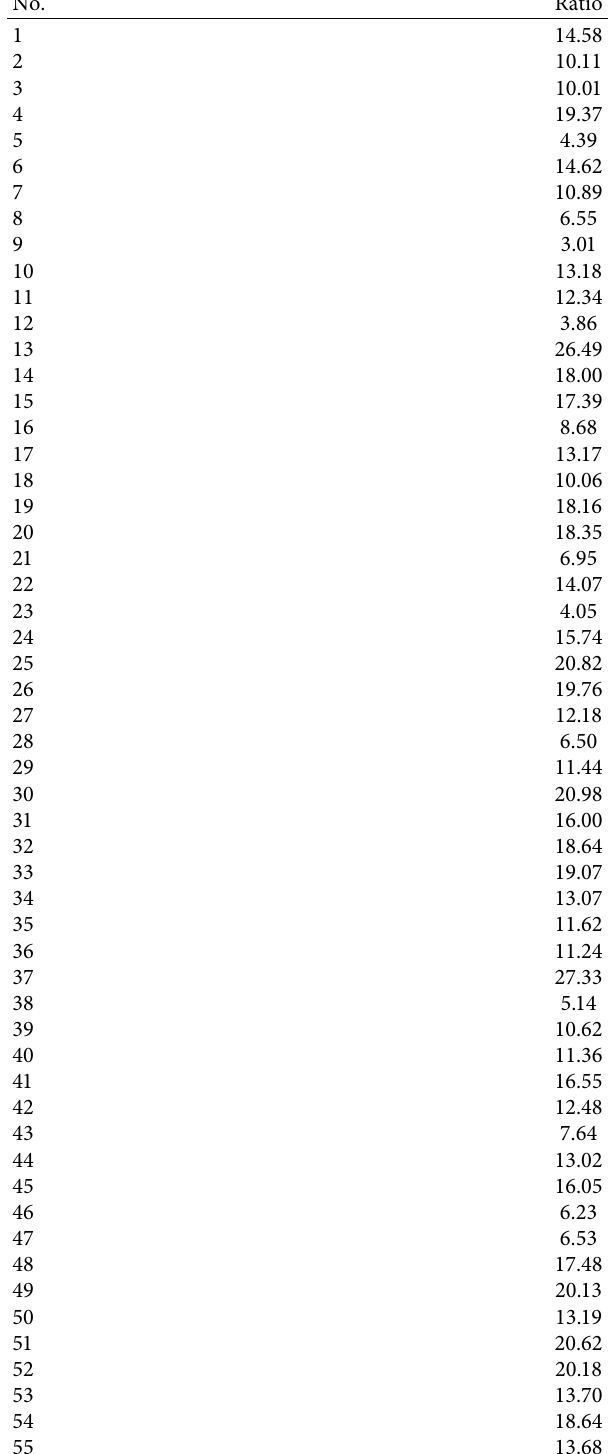
Table 7: Ratio of the total content of three chromone aglycones to the total content of six